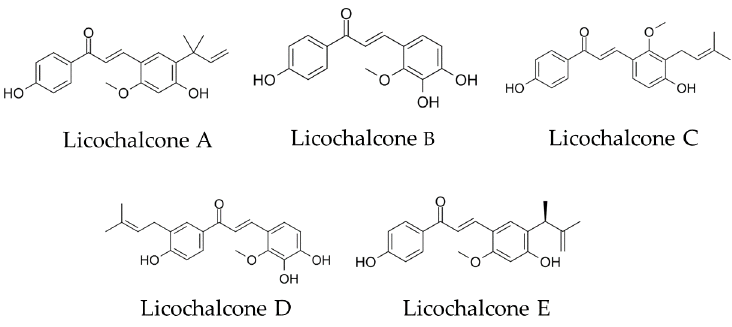
Figure 1. Chemical structural formula of licochalcones A, B, C, D and E.